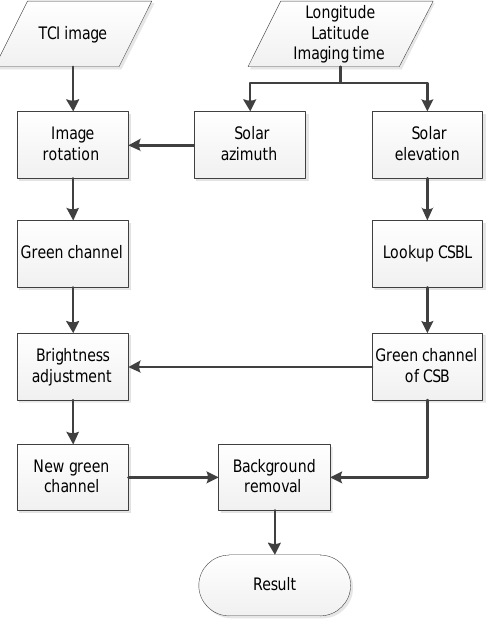
Figure 2. Flowchart of the proposed